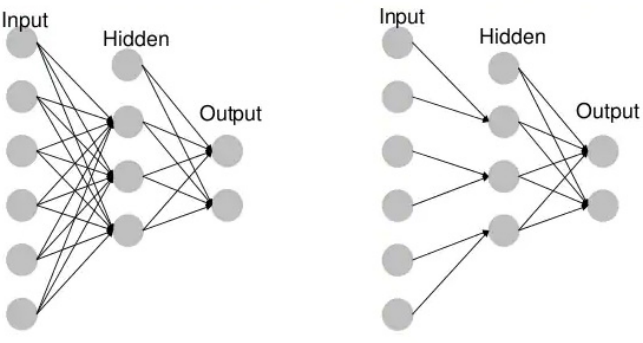
Figure 3. Example MLP vs. CNN.